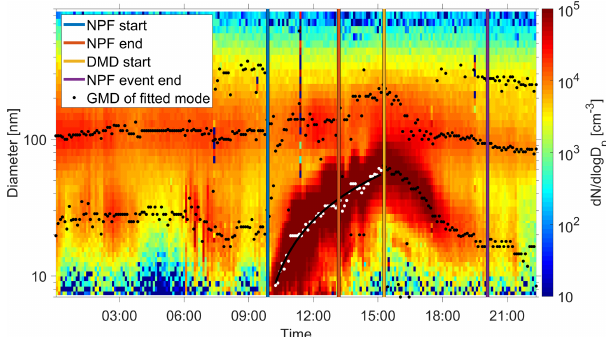
Figure 1. Particle number size distribution measured by DMPS showing an NPF event with a decreasing mode mean diameter (after 15:00LT; UTC + 3) in Hada Al Sham on 3 February 2014. The fig- ure also illustrates the times describing the progression of the NPF events with colored vertical lines (NPF start – blue, NPF end – or- ange, DMD start – yellow, and NPF event end – purple) and the geometric mean diameters (GMDs) of fitted modes with black cir- cles. The GMDs selected for the calculation of the growth rate are shown using white circles, and the black curve shows the linear fit to these